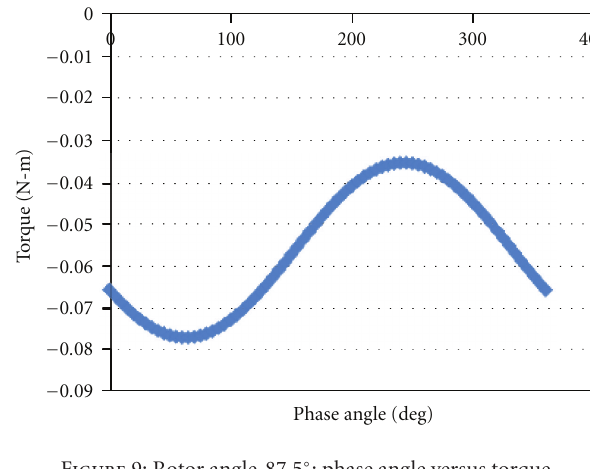
Figure 7: Rotor angle-00 ◦ : phase angle versus torque.